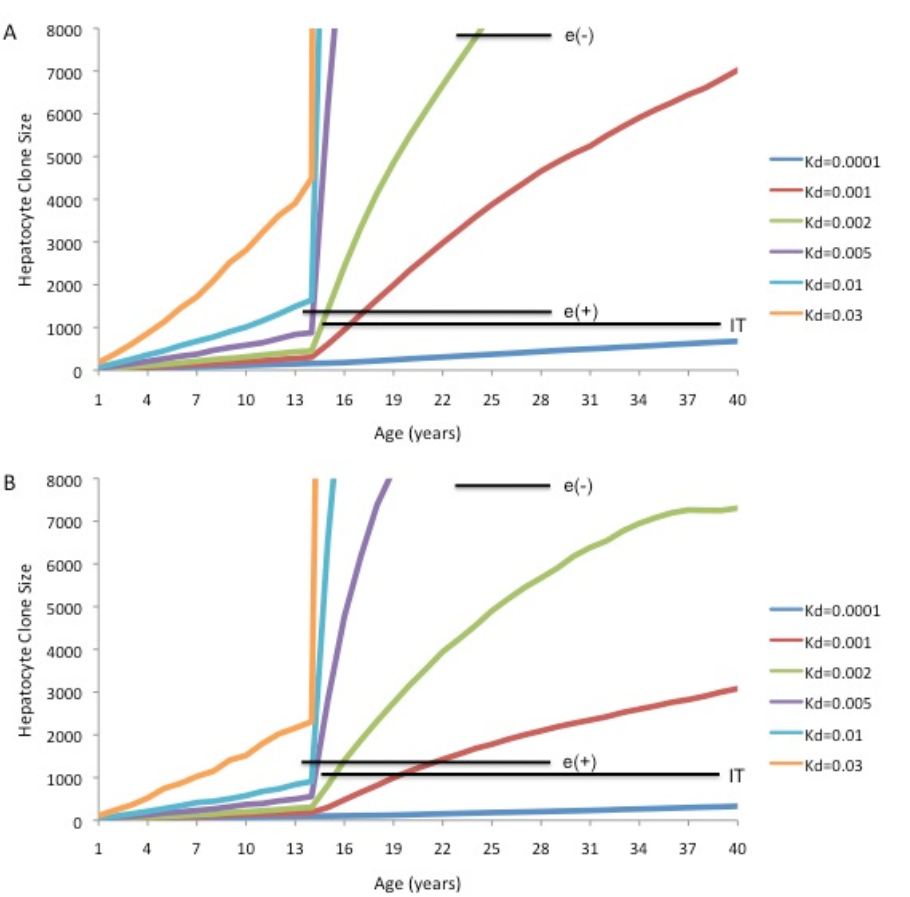
Figure 7. Computer modeling of maximum predicted hepatocyte clone sizes if homeostasis in the adult liver is maintained by TERT-high hepatocytes (Model 3): Maximum hepatocyte clone sizes were calculated for the indicated daily death rates (e.g., 0.2% per day, Kd = 0.002) using the Fortran were assumed to represent 3% of the hepatocyte population throughout. During the growth phase of the liver, the TERT-high hepatocytes were assumed to be a self-contained population that did not differentially contribute to liver homeostasis. Once the liver reached full size, they were assumed to have a seven-fold growth advantage over TERT-low hepatocytes, giving rise to both TERT-high and TERT-low hepatocytes [68]. Both TERT-high and TERT-low hepatocytes were assumed to die at the indicated daily rates. The horizontal bars show the geometric mean of maximum hepatocyte clone sizes observed using inverse-nested PCR assays for integrated HBV DNA in a study of three different groups of patients with chronic infection: immune tolerant (IT), immune active HBeAg-positive (e(+)), and immune active HBeAg-negative (e(-)) [75]. The bars span the ages covered by each group of patients. ( A ) Maximum clone size predictions assuming 100% of hepatocytes had lineage-specific markers at birth. ( B ) Maximum clone size predictions assuming only 1.0% of hepatocytes had detectable lineage-specific markers (e.g., randomly integrated HBV DNA) at